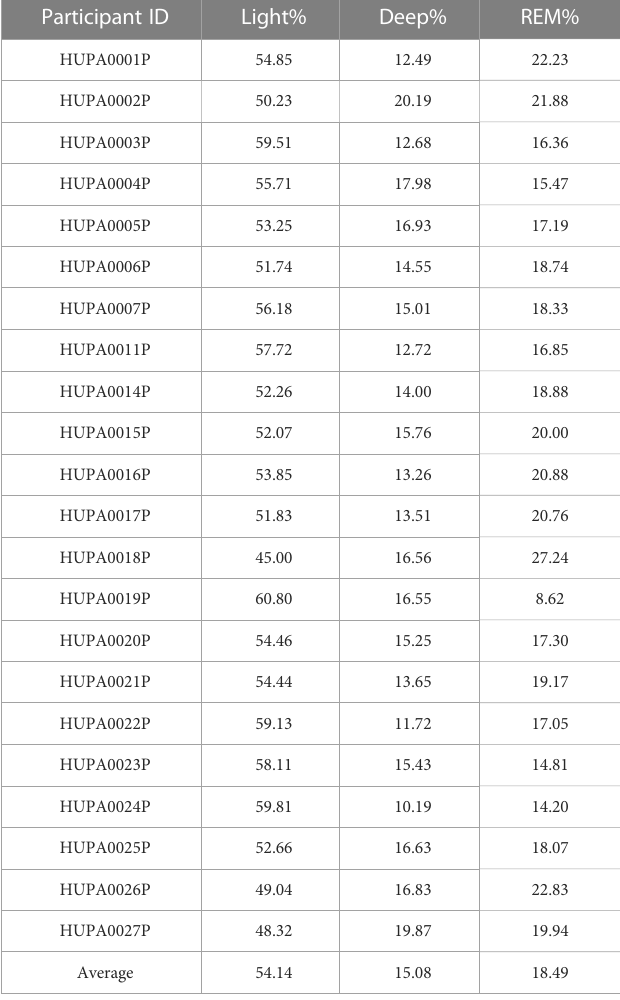
TABLE 5 Sleep States: Ratio over Total Sleeping Time. Participant